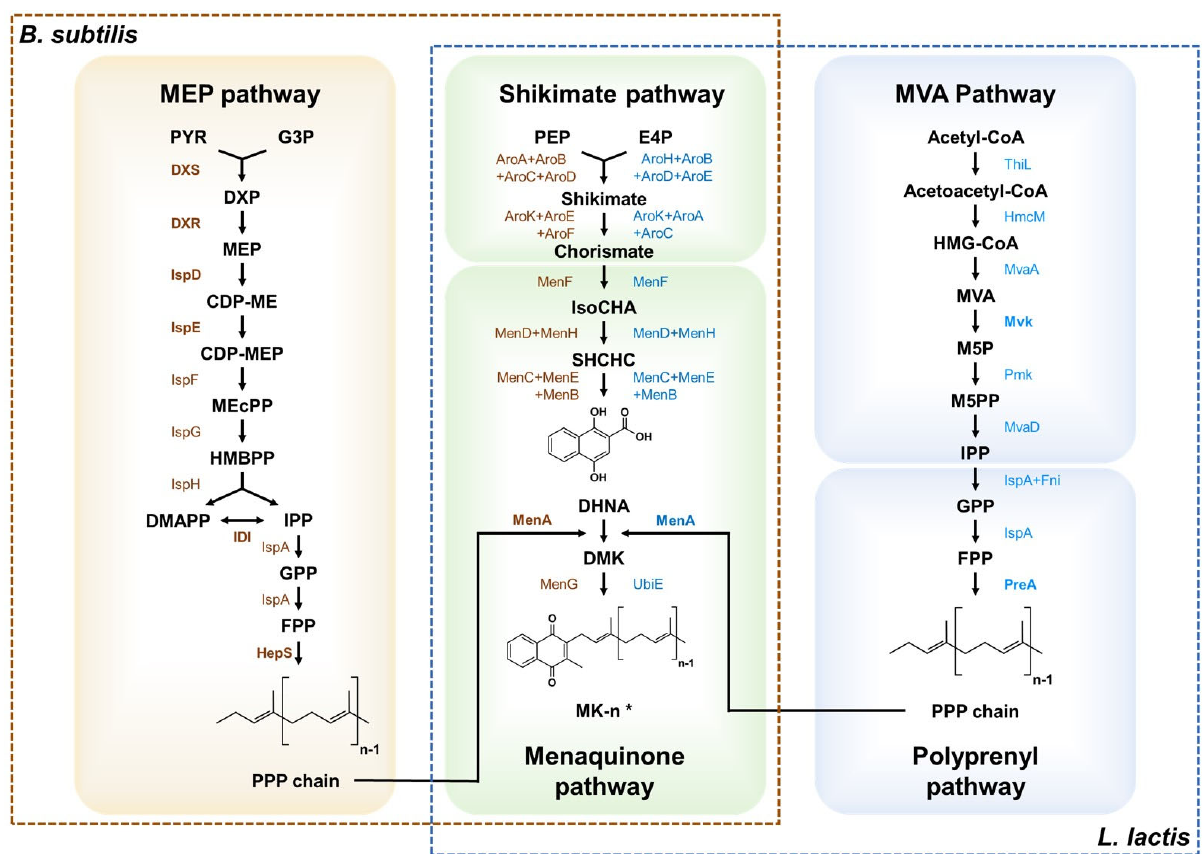
Figure 2. Biosynthetic pathway of menaquinone in Bacillus subtilis and Lactococcus lactis covered in this review. Metabolic pathways engineered in microorganisms for production of vitamin K were displayed. The prenyl chain structures are synthesized by the MEP pathway in B. subtilis and by the MVA pathway in L. lactis subsp . cremoris . The naphthoquinone ring structure is synthesized by the shikimate pathway and connected to side chains by the menaquinone pathway. The brown square with a dotted line refers to the pathway of menaquinone ‐ 7 synthesizing in B. subtilis . The blue square with a dotted line refers to the pathway of menaquinones synthesizing in L. lactis subsp . cremoris . The enzymes in bold were overexpressed to increase vitamin K production in the previous studies .